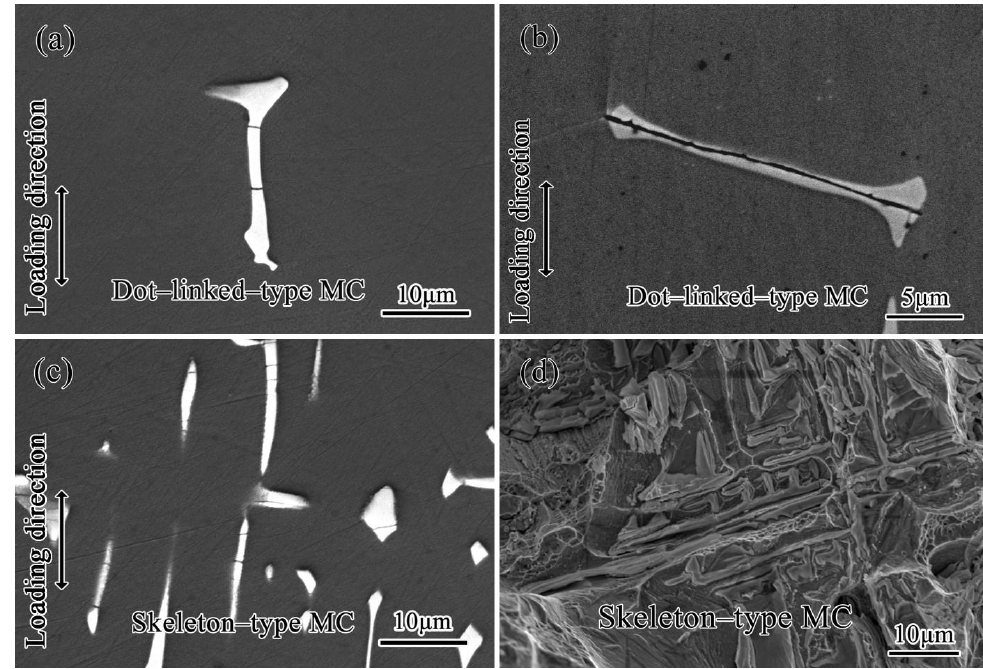
Figure 7. Morphology of the MC carbide breakers under different angles between the MC carbide and tensile loading direction. ( a , c ) They show smaller microcracks in size when θ is smaller than 45 ◦ . ( b , d ) They show larger microcracks in size when θ is greater than 45 ◦ . ( a – c ) They show the carbide morphology of the longitudinal section. ( d ) It shows the carbide morphology of the fracture surface.